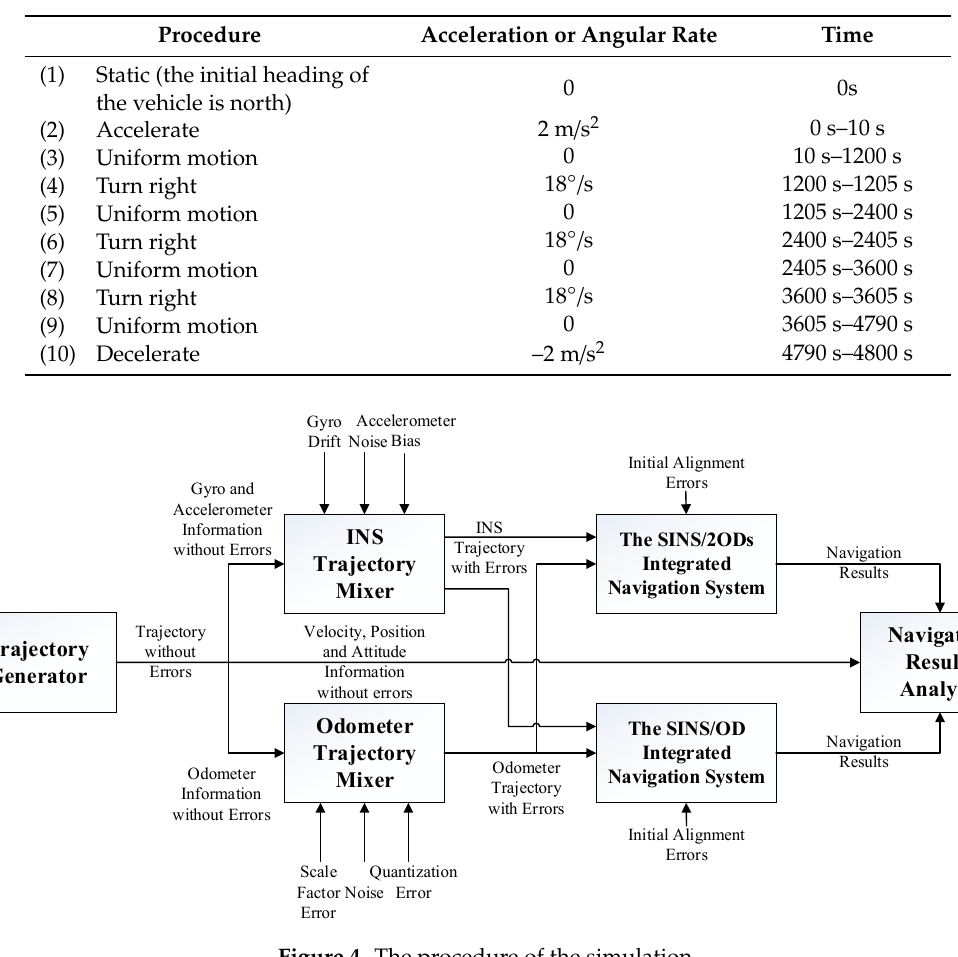
Figure 4. The procedure of the simulation. Table 3. The trajectory of the land vehicle.